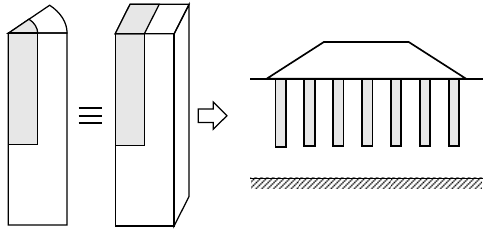
Figure 8. Calibration of the parameters of longitudinal gravel trenches using the unit cell model as an auxiliary problem.